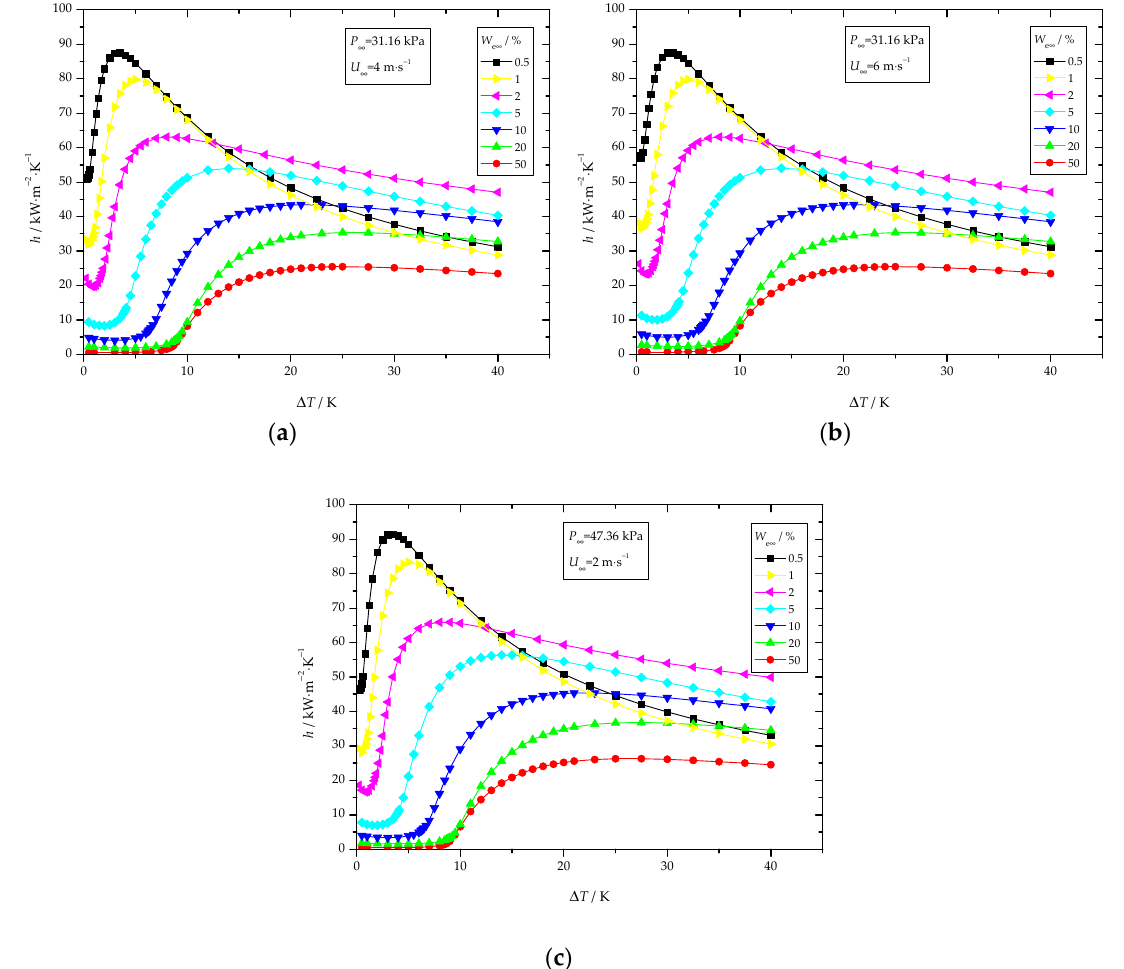
Figure 5. Calculation results of condensation heat transfer coefficients at ( a ) P ∞ = 31.16 kPa, U ∞ = 4 m·s − 1 ; ( b ) P ∞ = 31.16 kPa, U ∞ = 6 m·s − 1 ; ( c ) P ∞ = 47.36 kPa, U ∞ = 2 m·s − 1 .